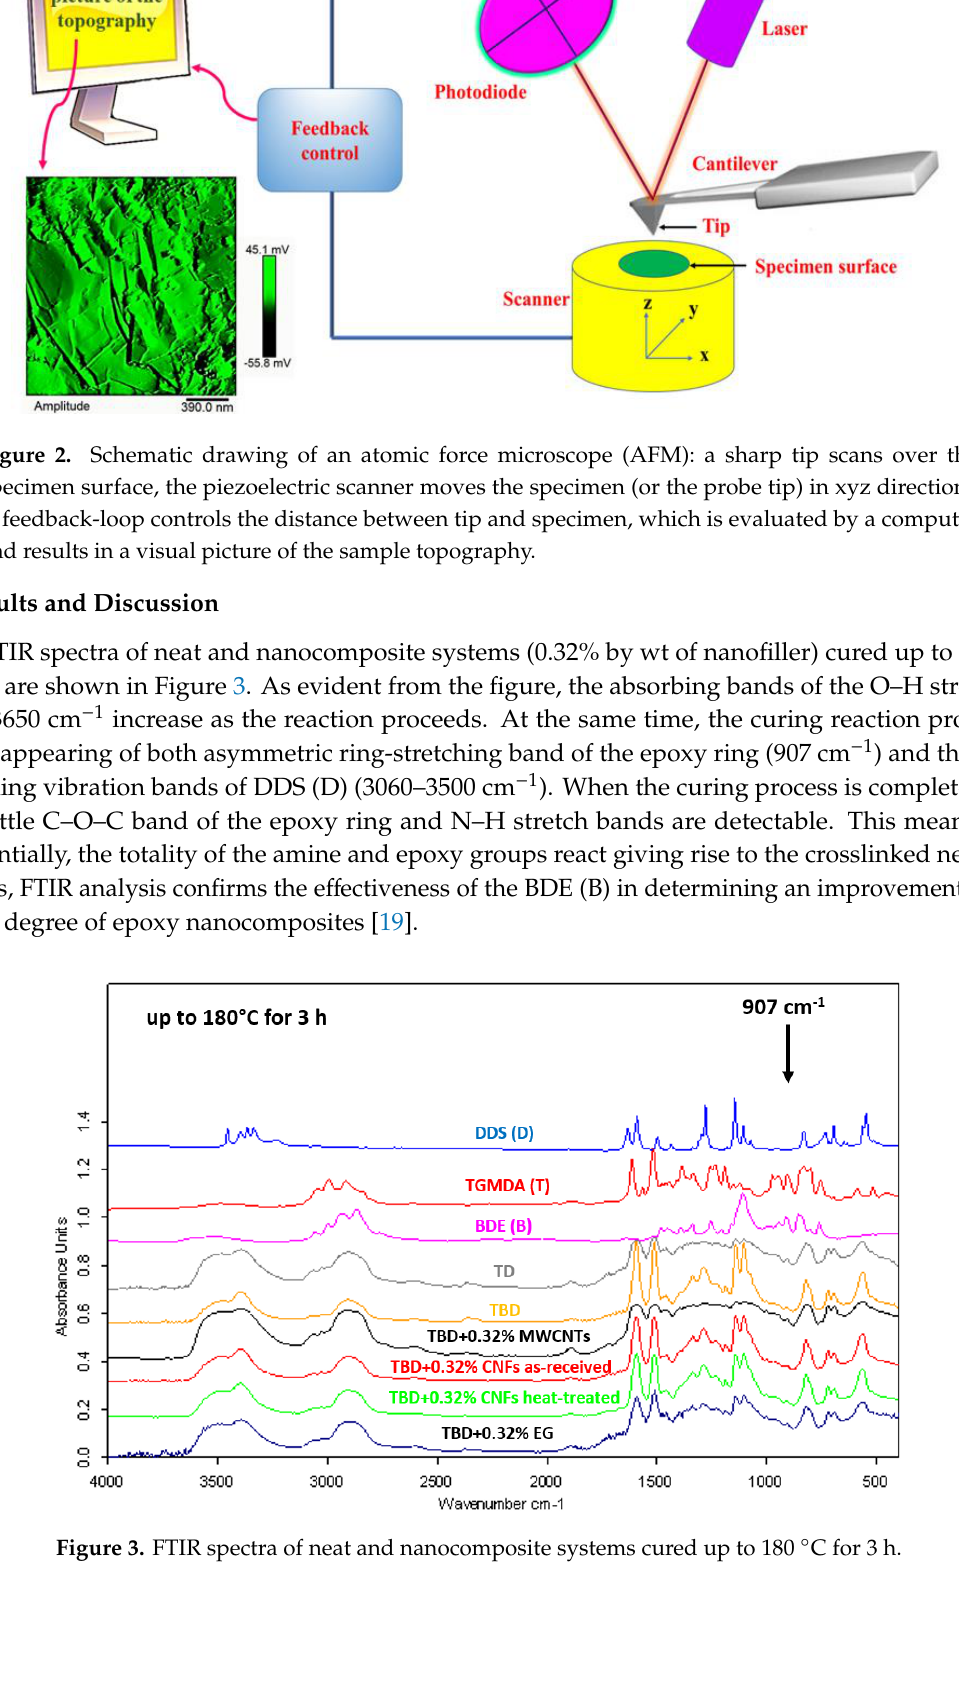
Figure 4. FTIR spectra of neat and nanocomposite systems cured up to 125°C for 1 h. The effect of the reactive diluent BDE (B) on the viscosity of the epoxy matrix has been studied in previous papers [17,18]. As stated above, when it is mixed with the TGMDA (T) epoxy precursor, it decreases the viscosity of the epoxy matrix. The decrease of the amount of the epoxy groups of the TBD sample with respect to the TD sample is most likely due to the reduction of the viscosity of the